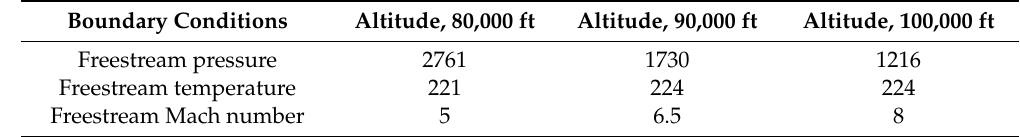
Table 4. Boundary conditions for computational analysis.